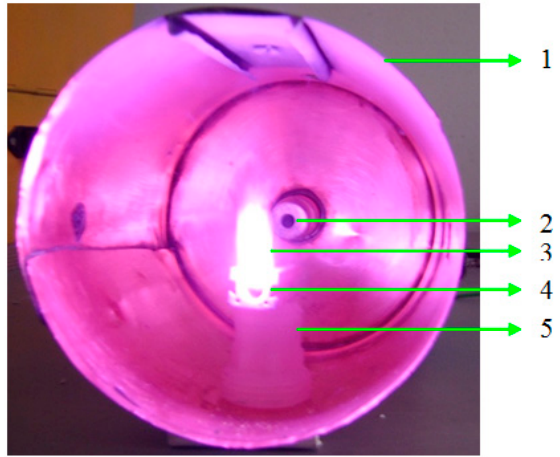
Figure 3. The metallic wire exposed to the microwave field: 1—cylindrical cavity, 2—magnetron antenna, 3—metallic plasma, 4—ceramic support, 5—plastic support.